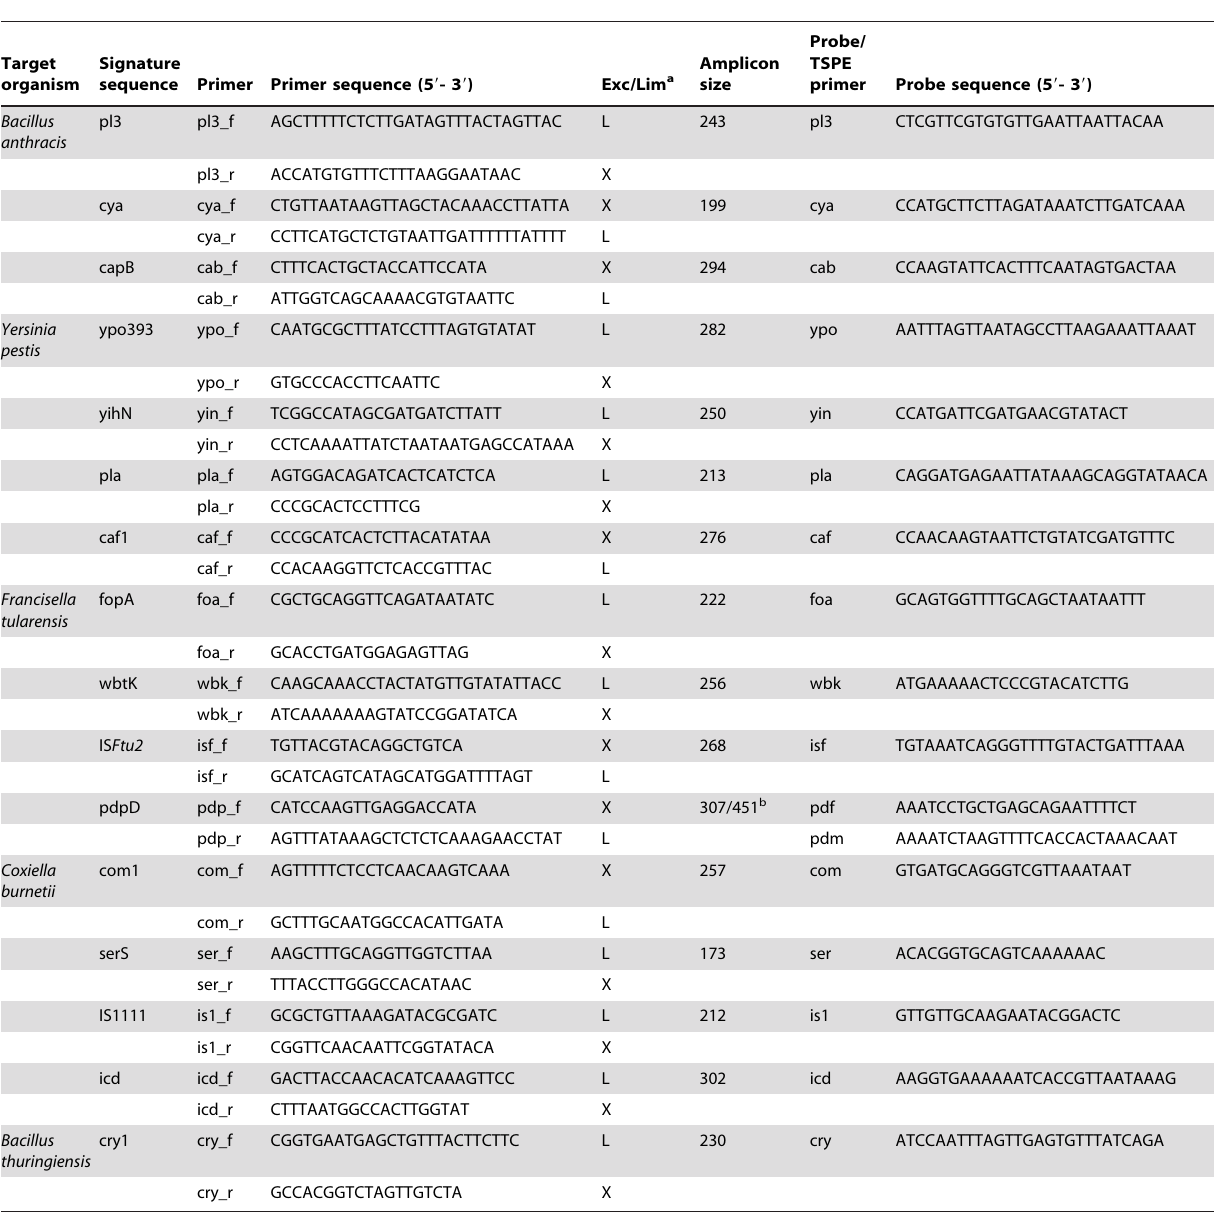
Table 1. Oligonucleotides used for amplification and labeling of signature sequences and as fixed